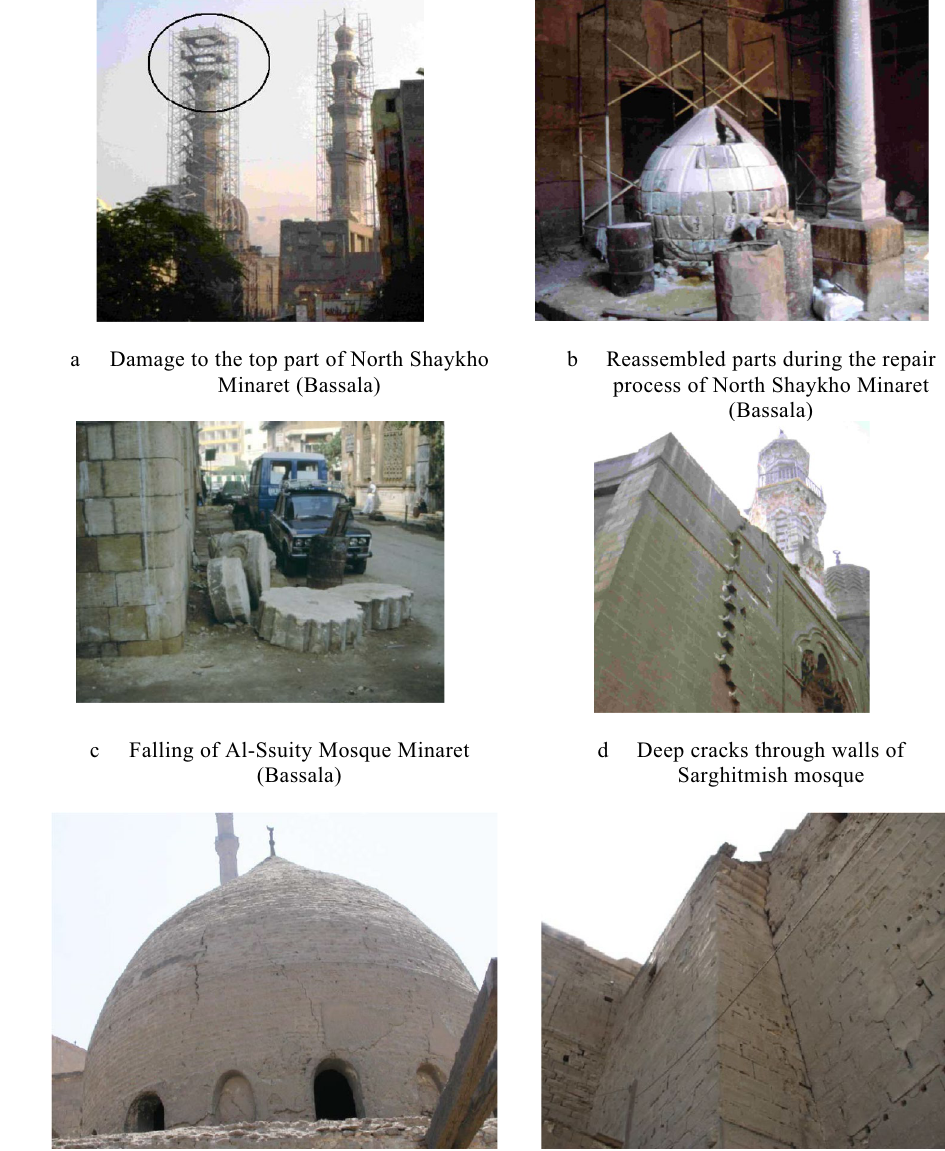
Fig. 3 Miscellaneous observed damage upon 1992 Cairo earthquake [14]